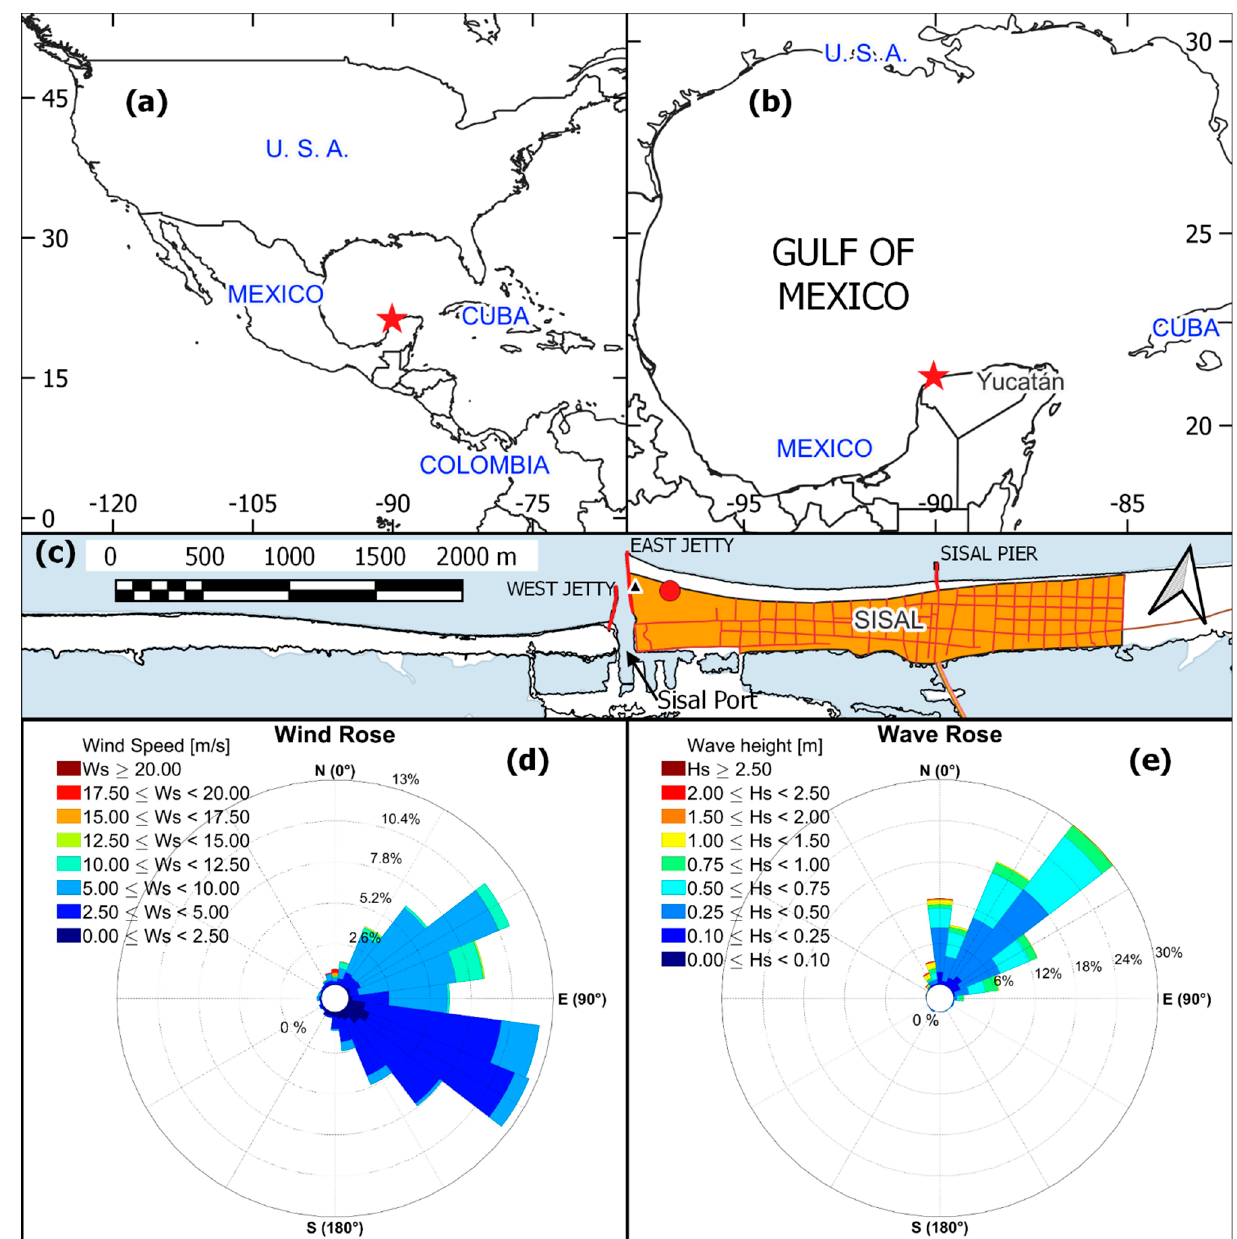
Figure 1. Study site location maps. ( a ) Global location; ( b ) Gulf of Mexico and the Yucatan Peninsula; red star marks the study site area in ( a , b ); ( c ) Sisal port (nearly 95,000 m 2 ), Sisal community (orange polygon); the red circle is the camera system tower location and the black triangle is the position of the anemometer; the red lines are (from west to east) West Jetty, East Jetty, and Sisal Pier; the black line represents the coastline (sea to the north, wetlands to the south of the barrier island); ( d ) wind speed rose; ( e ) wave height rose (ADCP location is 10 km offshore of Sisal at 21°16.475 ′ N, − 90°3.045 ′ W).